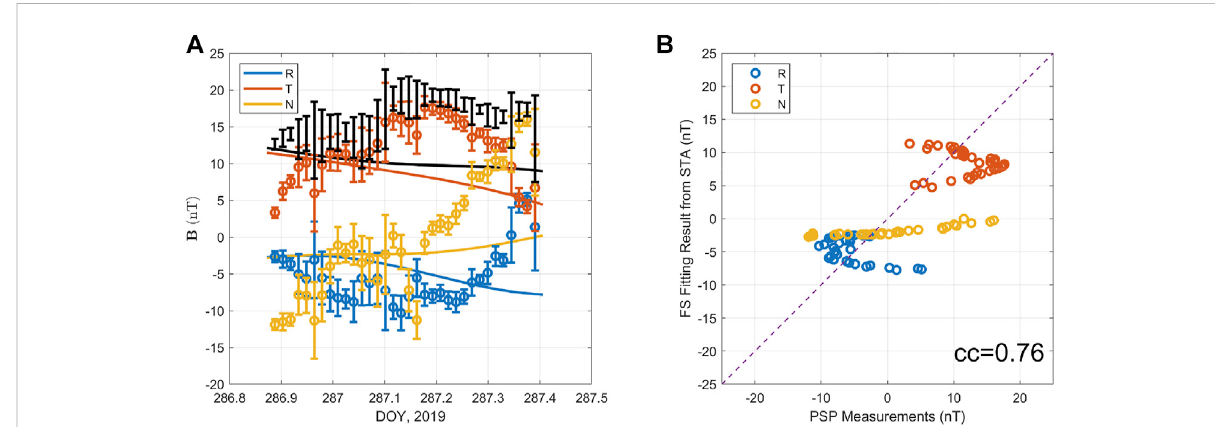
FIGURE 7 (A) The comparison between the FS model output (smooth curves) based on the optimal fi tting to STA data only and the actual measurements (errorbars),alongthePSPspacecraftpath,asillustratedinFigure6. (B) Thecorrespondingcomponent-wisecorrelationplotbetweenthetwosetsof data, yielding an overall correlation coef fi cient cc =0.76. The diagonal dashed line indicates the one-to-one line. The corresponding correlation coef fi cients for each magnetic fi eld component in the RTN coordinates are -0.46, -0.14, and 0.91, respectively.